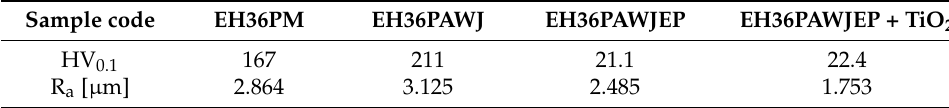
Table 6. Values of surface roughness and Vickers microhardness, HV 0.1 .